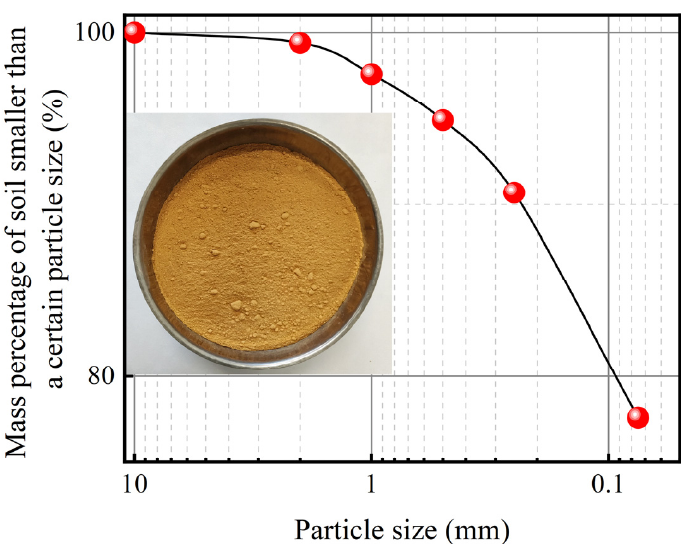
Figure 1. Grading curve of original soil sample. Table 1. Fundamental physical parameters of high liquid limit soil.